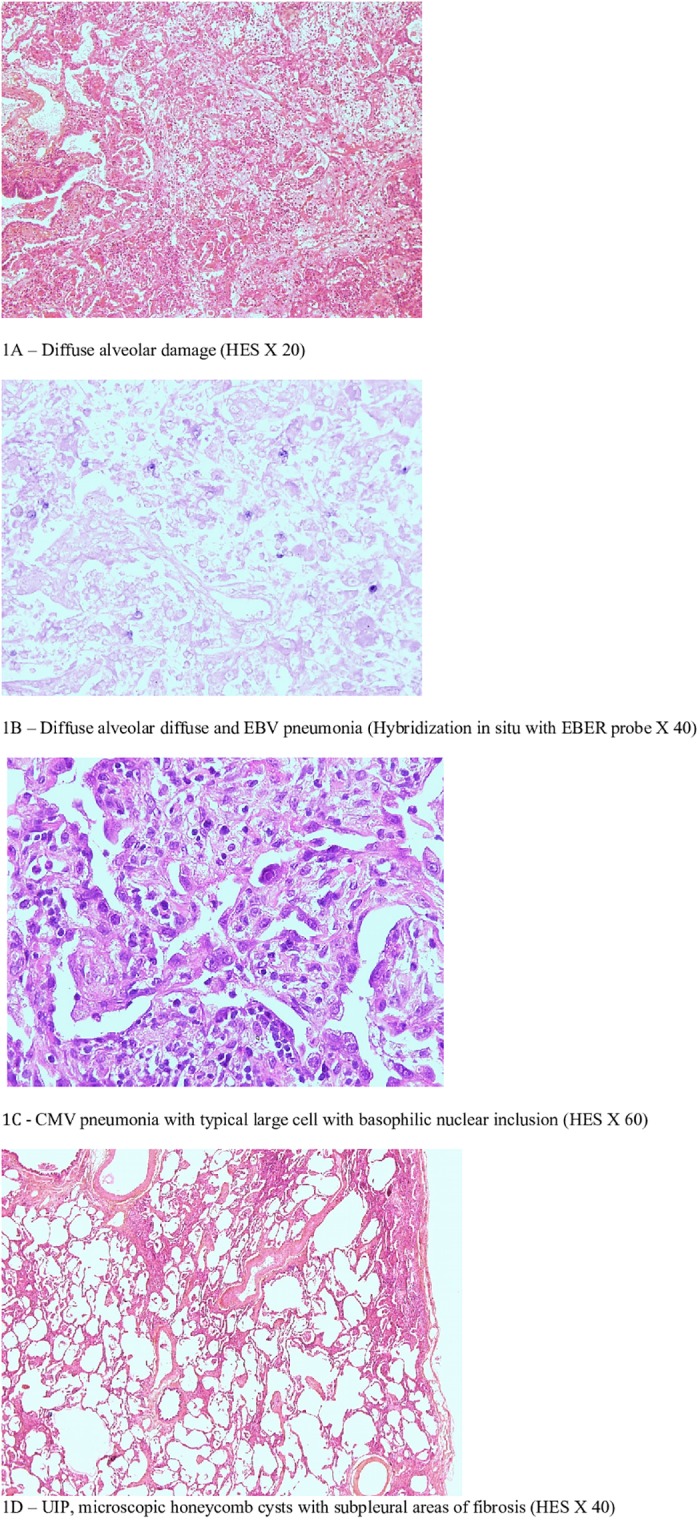
Panel of histologic patterns: DAD, UIP, and infectious pneumonia.1A –Diffuse alveolar damage (HES X 20). 1B –Diffuse alveolar diffuse and EBV pneumonia (Hybridization in situ with EBER probe X 40). 1C - CMV pneumonia with typical large cell with basophilic nuclear inclusion (HES X 60). 1D –UIP, microscopic honeycomb cysts with subpleural areas of fibrosis (HES X 40).